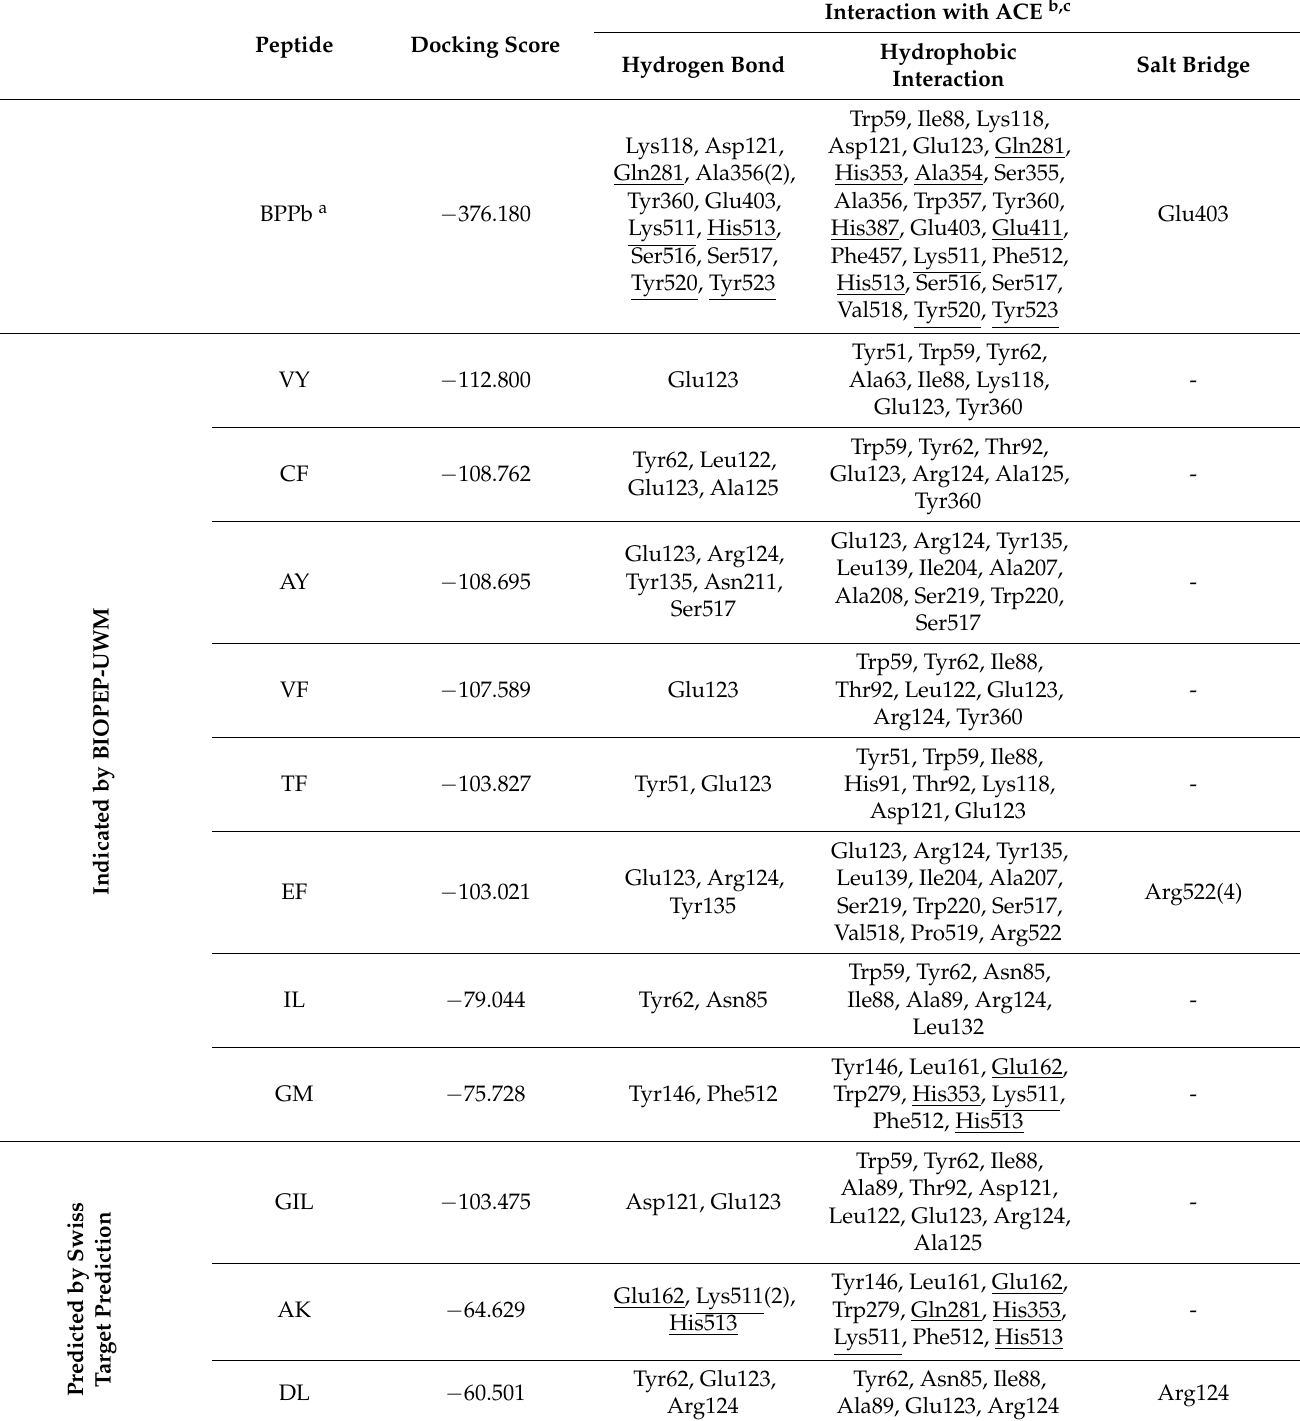
Table 5. Docking scores and intermolecular interactions between ACE and known/predicted anti- ACE peptides.